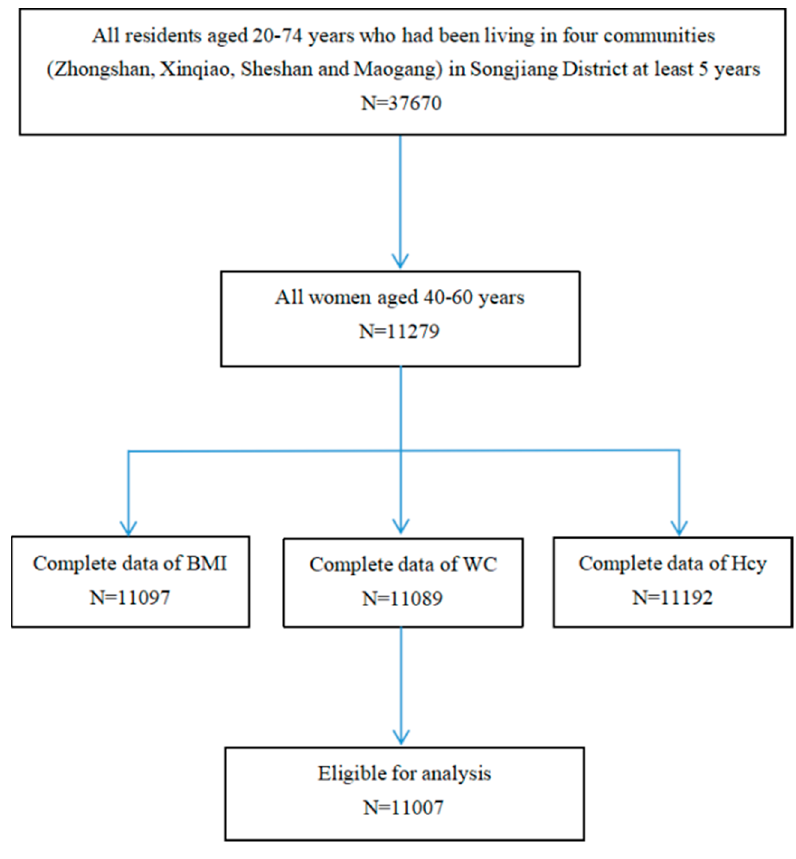
Figure 1. Flow chart for the study.